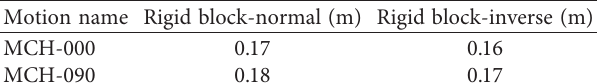
Figure 7: Postliquefaction yield acceleration of building No. 4 at MBARI facilities. Table 4: Lateral spreading calculated by the simplified method (the reported displacement is reported as